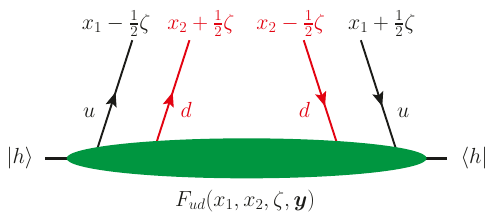
Figure 1 . Graphical representation of a skewed DPD for quark flavours u and d in the hadron h . The configuration shown is for the case where all momentum fractions given at the top of the graph are